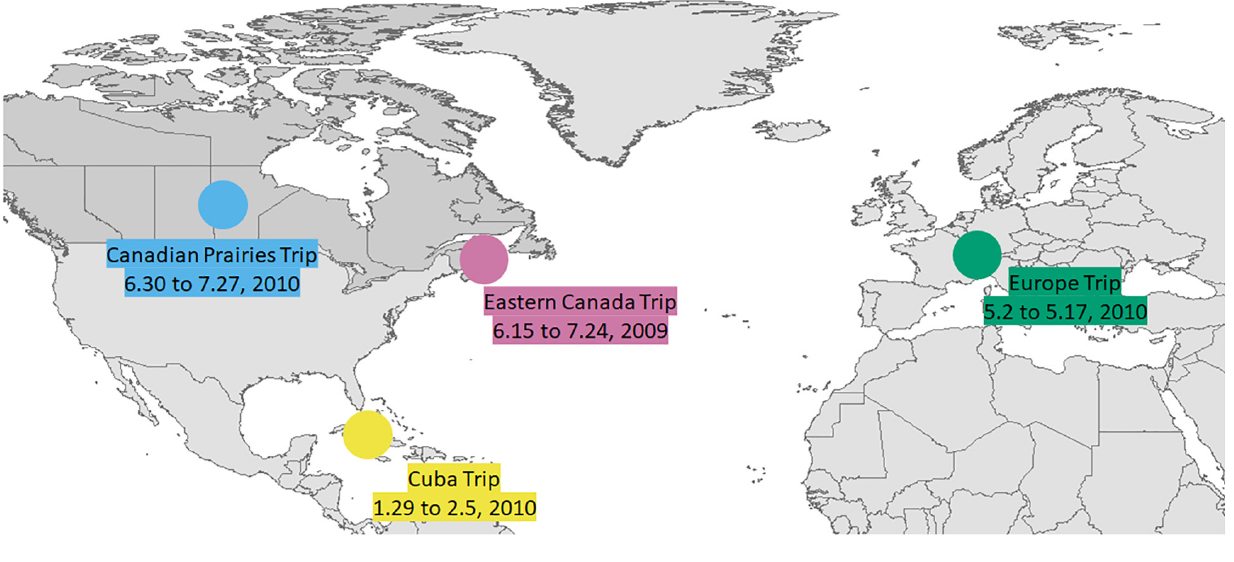
FIGURE 1 | Map showing four major